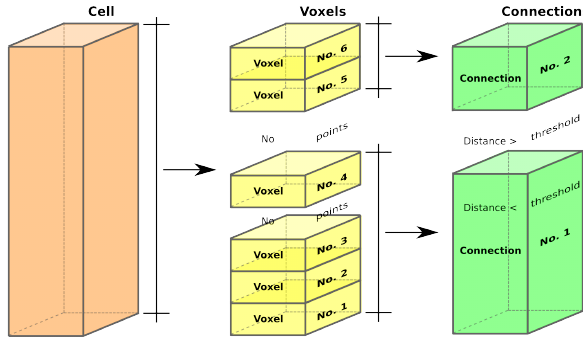
Figure 1: Basic concept: spatial discretization of the ALS point cloud into cell-level (a, left), voxel-level (b, middle) and connection-level (c,